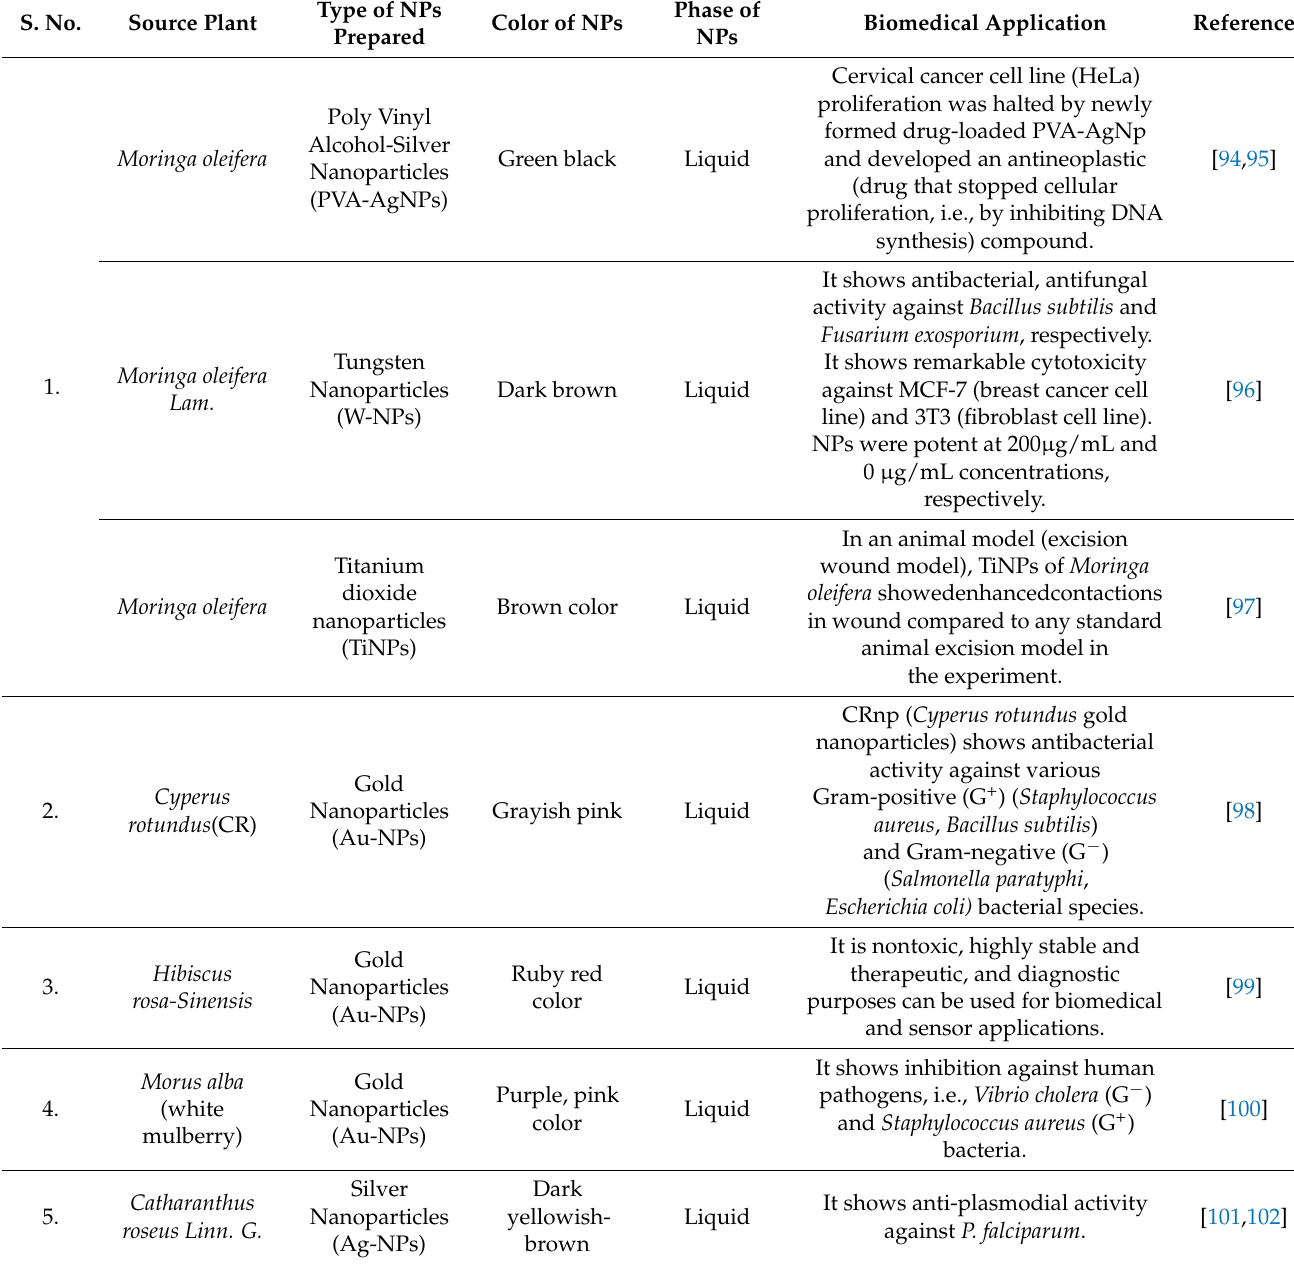
Table 1. Various biomedical applications of various plants-derived